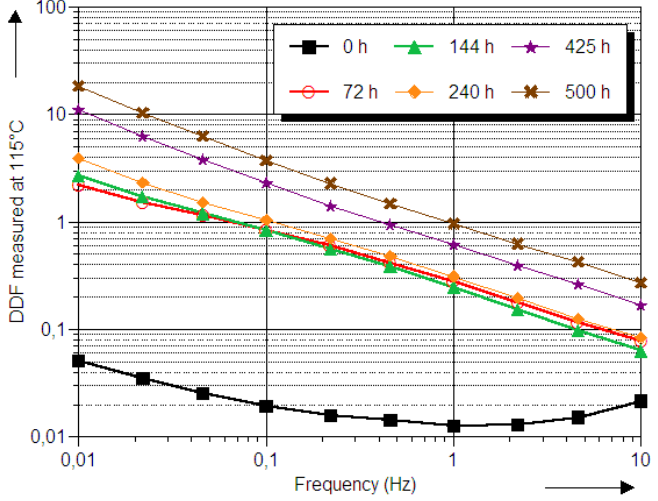
Figure 3. Zoomed view of Figure 2, in the frequency ranges from 0.01 to 10 Hz.